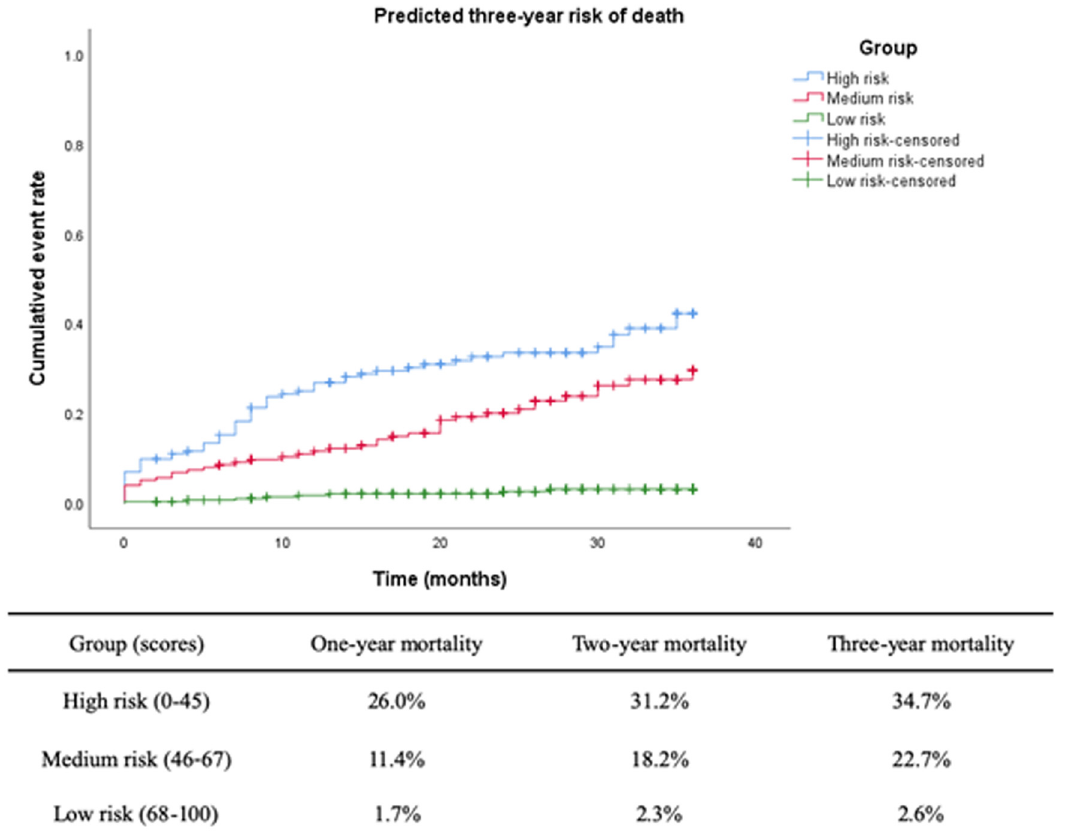
Figure 4: Cumulative risk of death predicted by the ABC - PI for di ff erent groups ( validation group, n = 651 ) . Abbreviations: ABC - PI, age - biomarker - clinical history prognostic